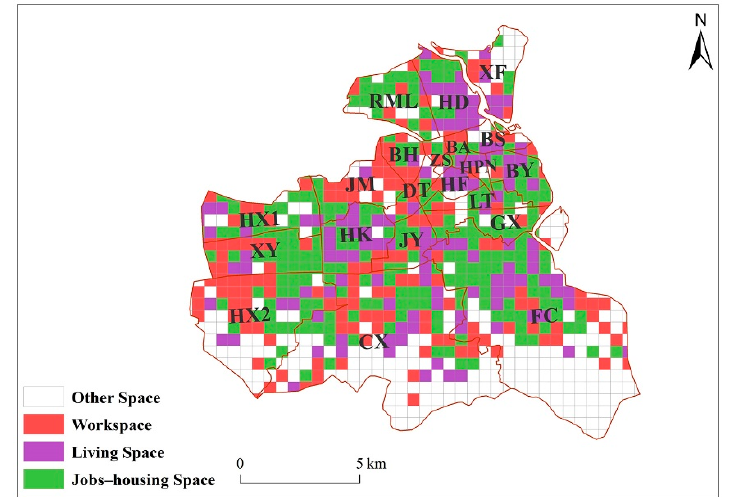
Figure 5. Recognition results of the travel flow model.